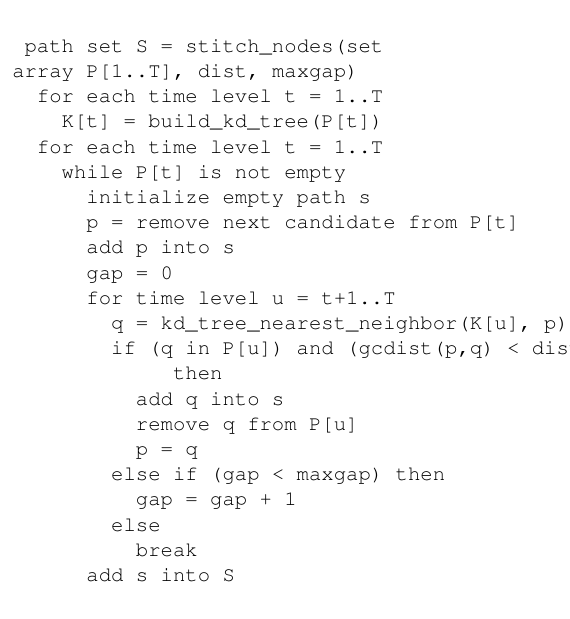
in order to maximize the efficiency of the search. Each can-